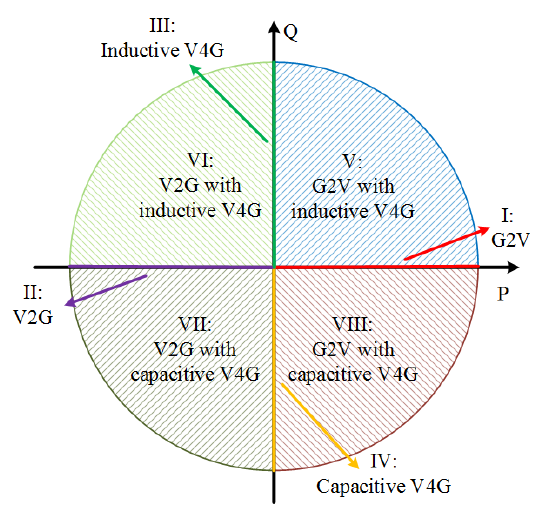
Figure 1. Four-quadrant operation for